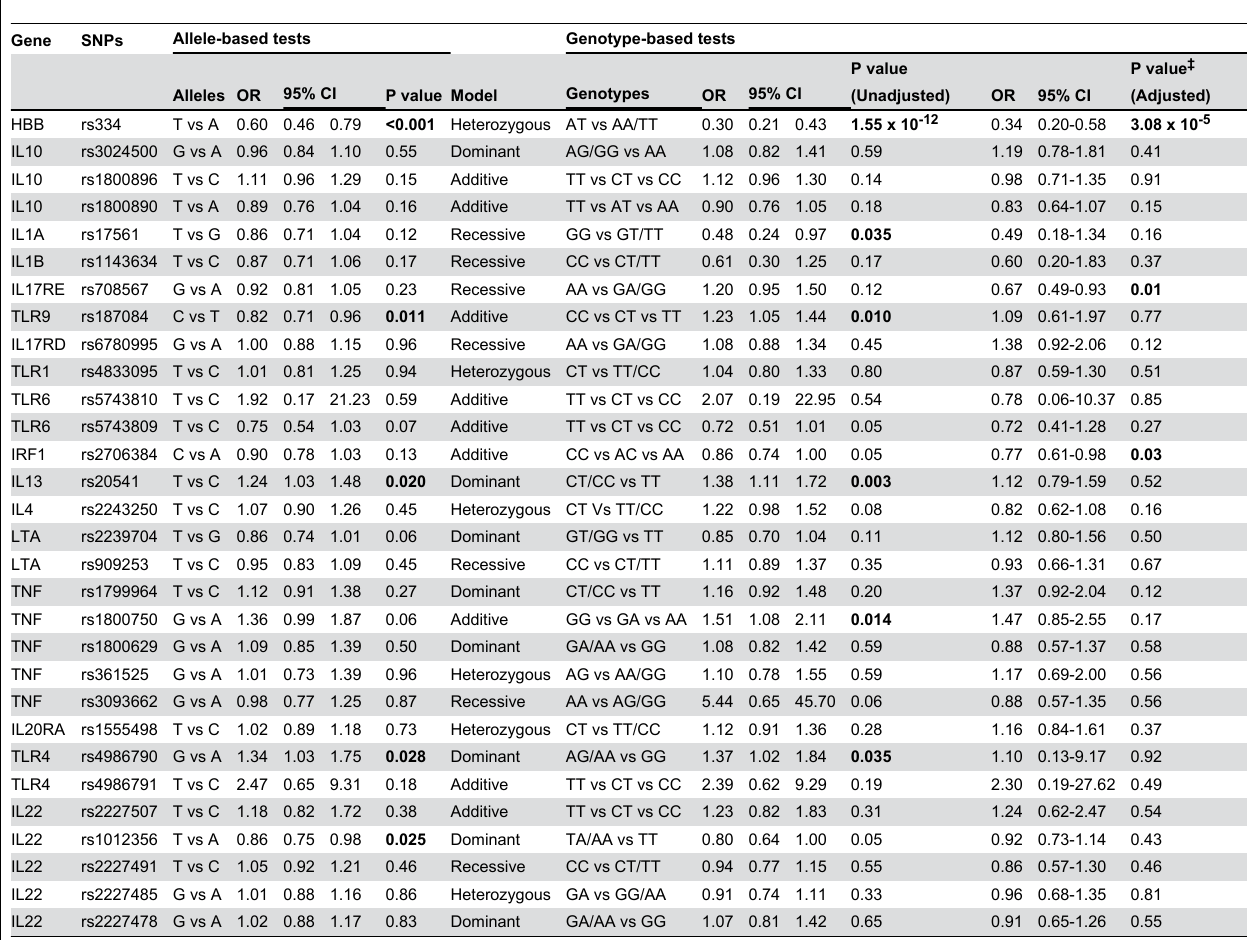
Table 3. Results of allelic and genotype associations between selected SNPs and